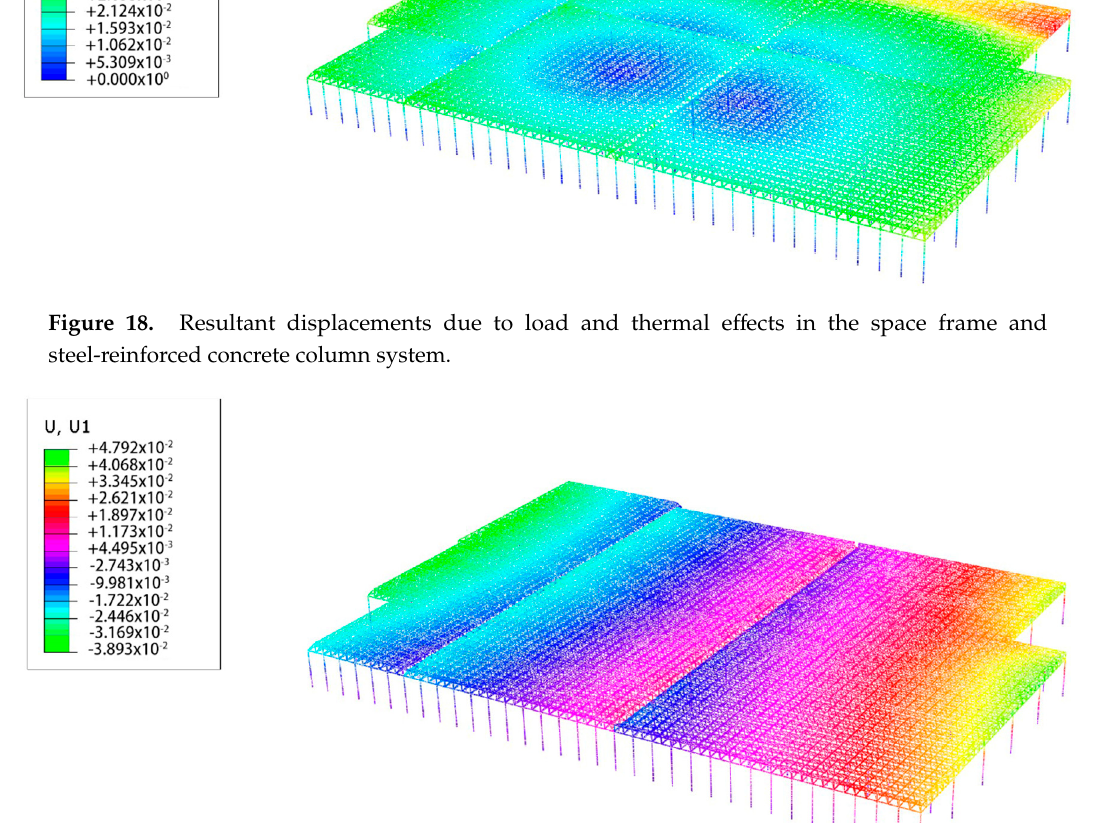
Figure 20. Displacements in the short-edge direction caused by load and thermal effects in the space frame and steel-reinforced concrete column system. Figure 21. Displacements in the vertical direction caused by the loads in the space frame and steel- reinforced concrete column system.